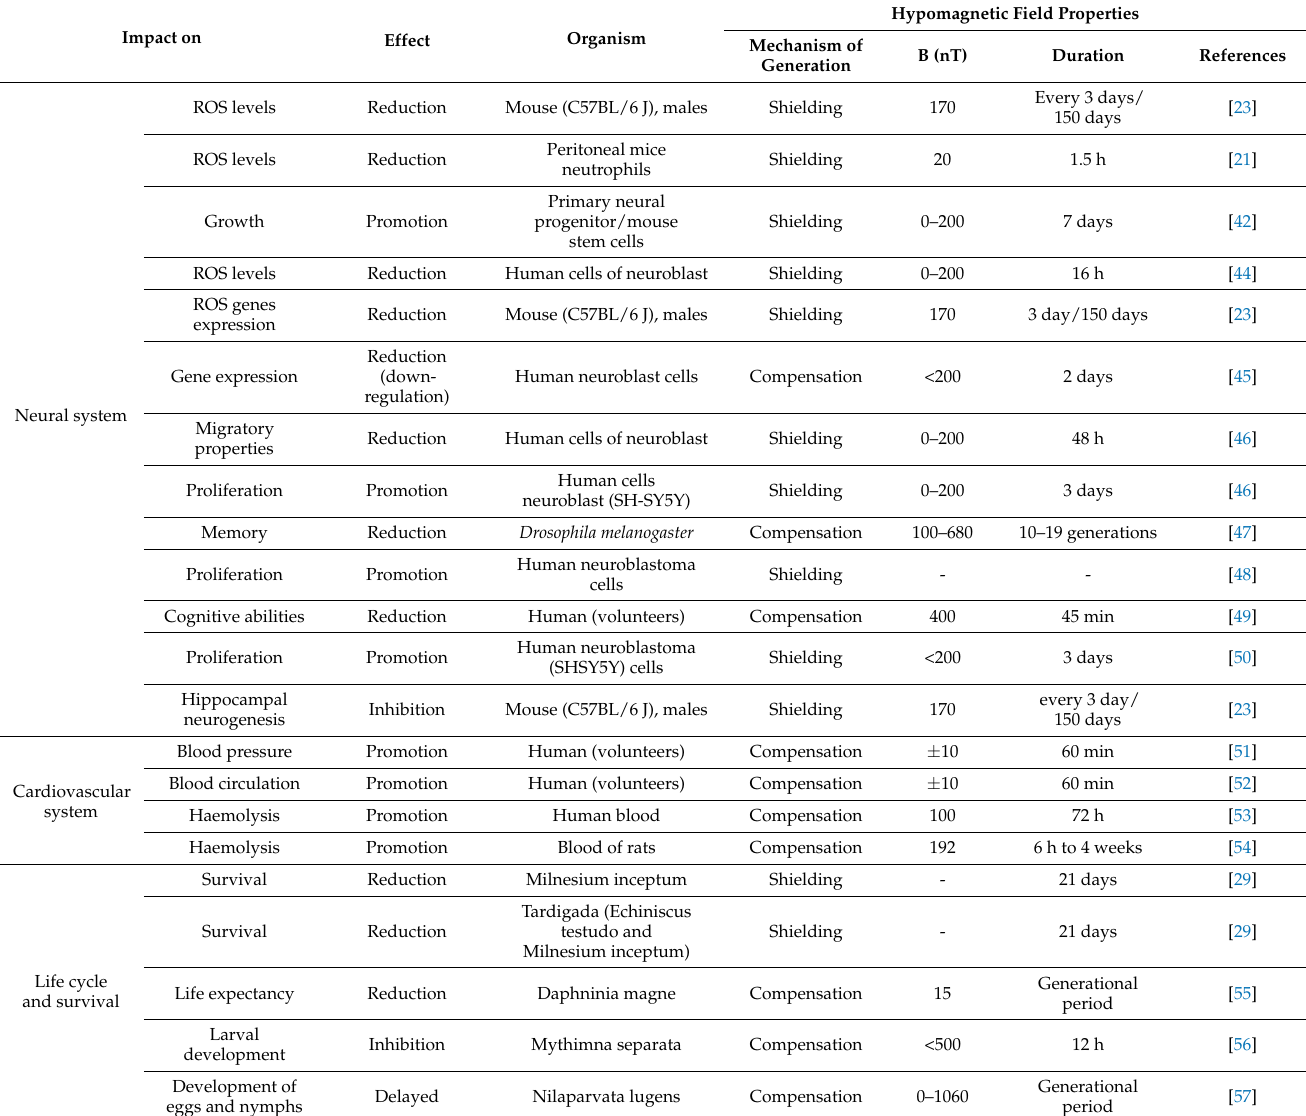
Table 2. Impact of hypomagnetic field on animal neural systems (B—magnetic flux density in Tesla